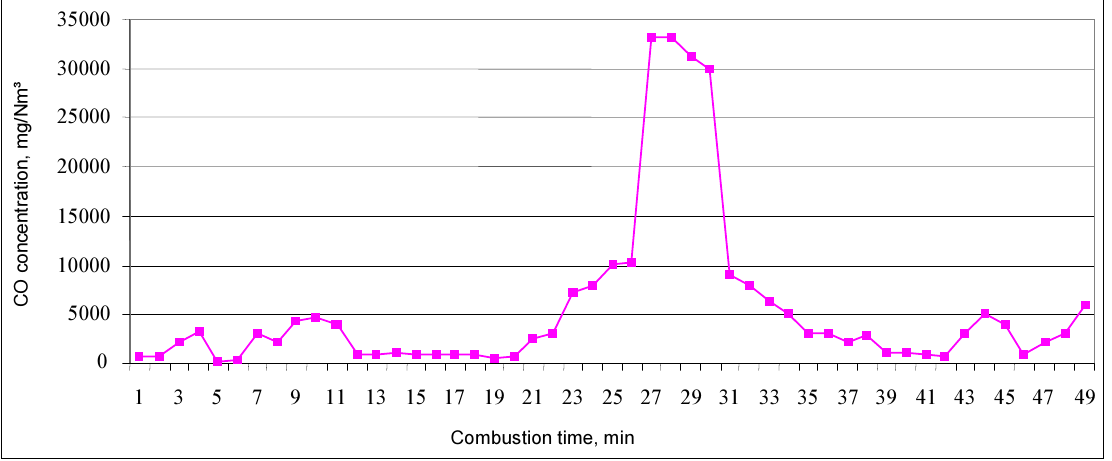
Fig. 6. Concentration of carbon monoxide in smoke burning fire-wood